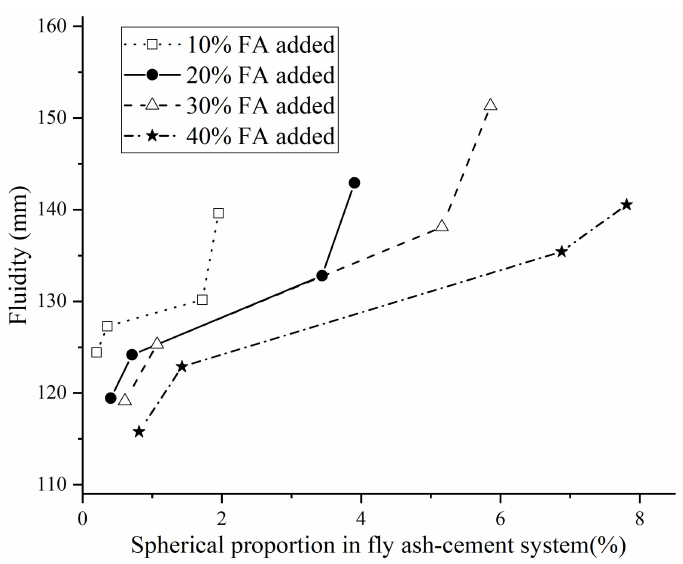
Figure 6. Relation of fluidity and spherical proportion (W/B =